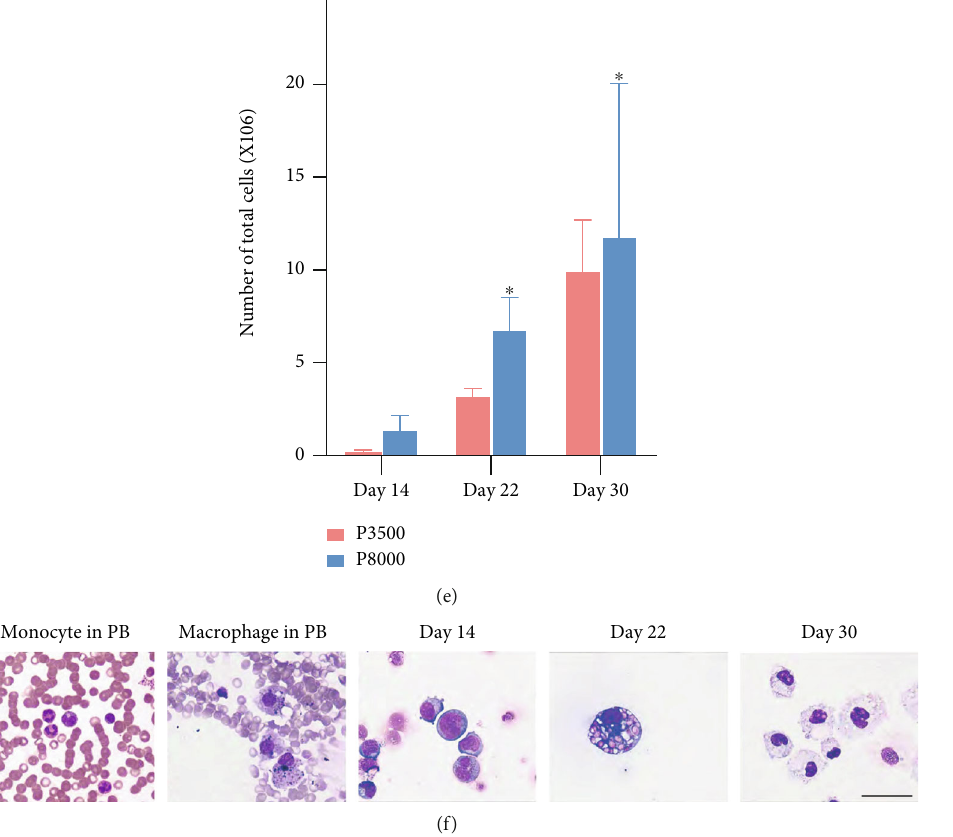
Figure 1: The quantity of seeding cells a ff ected the process of hiPSCs di ff erentiated into macrophages. (a) Schematic diagram of the protocols of macrophage di ff erentiation from hiPSCs. (b) Representative bright- fi eld images of EBs and cells at di ff erent time points during culture stages under two macrophage di ff erentiation protocols. Scale bars, 250 μ m. (c) The percentages of di ff erent cell types (CD34 + , CD45 + , CD45 + CD14 + , and CD45 + CD11b + ) produced during the di ff erent culture stages under two macrophage di ff erentiation protocols. (d) The percentage of CD34 + CD45 + cells at day 14 and CD45 + CD14 + /CD45 + CD11b + cells at day 14, day 22, and day 30 in two macrophage di ff erentiation protocols. ∗ P < 0 : 05 and ∗∗∗ P < 0 : 001 . (e) The total number of cells at day 14, day 22, and day 30 in two macrophage di ff erentiation protocols. ∗ P < 0 : 05 . (f) Representative Wright-Giemsa staining images of monocytes and macrophages in peripheral blood and cells di ff erentiated from hiPSCs at day 14, day 22, and day 30 in the P3500 protocol. Scale bar represents 50 μ